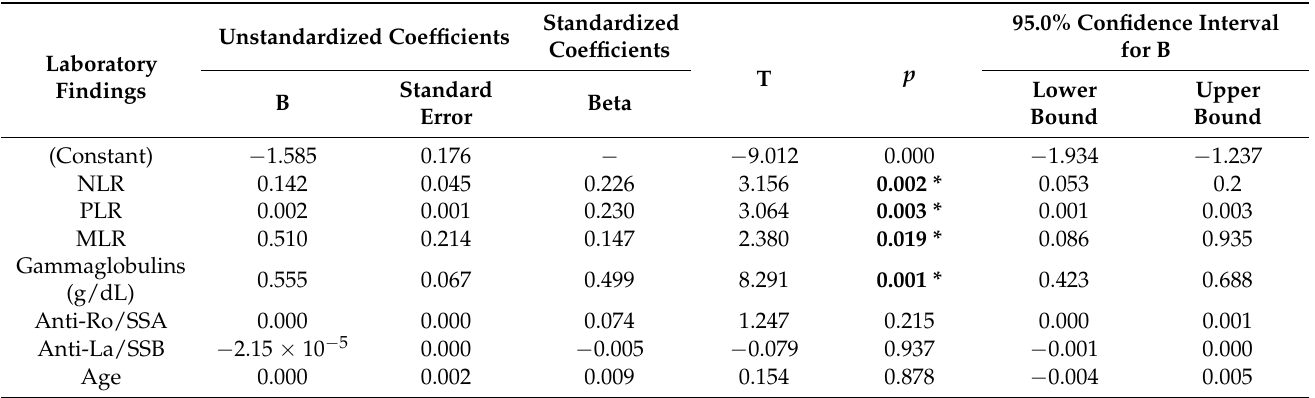
Table 4. Multiple linear regression analysis for the development of cutaneous vasculitis lesions in